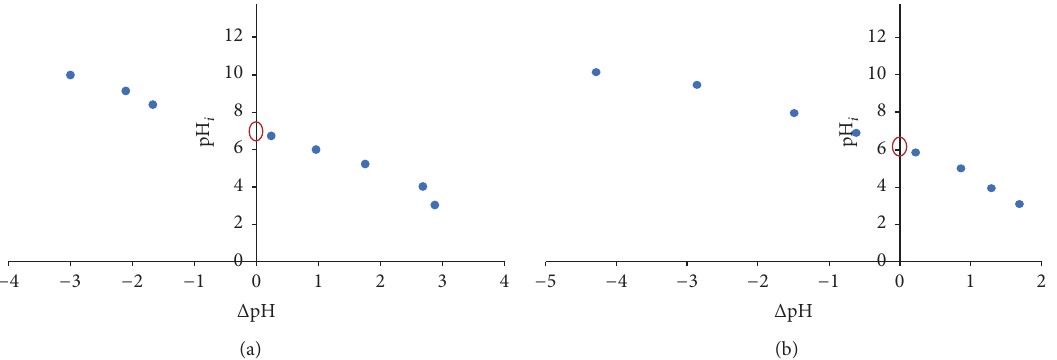
Figure 8: PZC of cryogels, 0.5 g cryogel mass, 20 mL NaCl solution at various pHs, 200 rpm, 303 K, a 24-hour period, closed atmosphere: (a) QE and (b) QEFe.